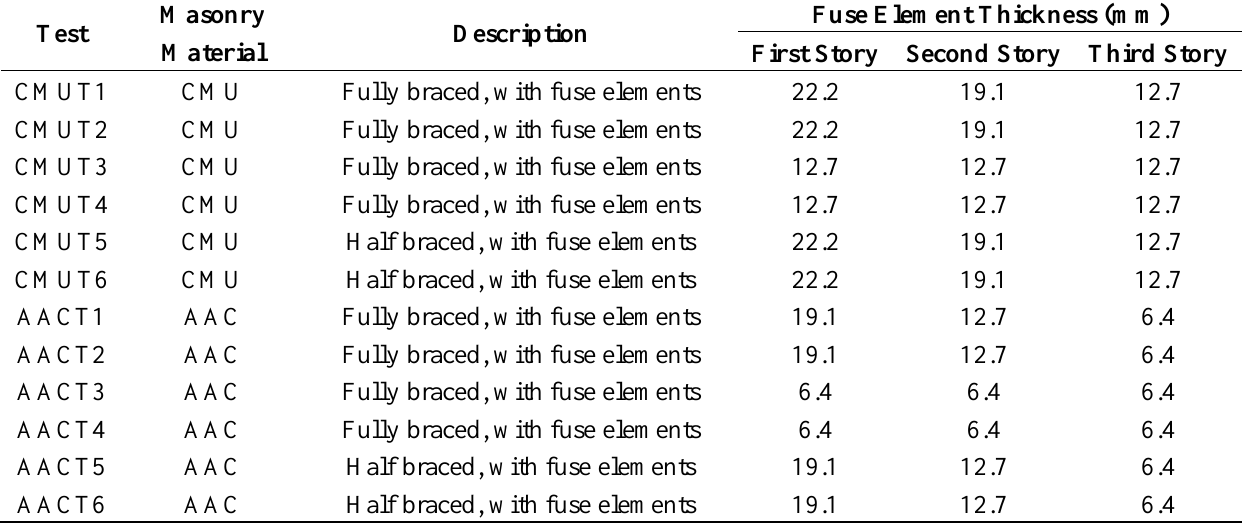
Table 4. Parametric testing program test matrix.